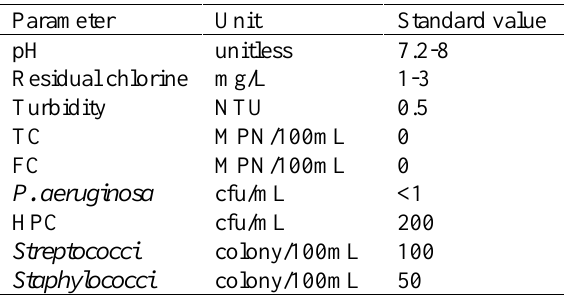
Table 1. The studied physical, chemical, and biological parameters along with standard